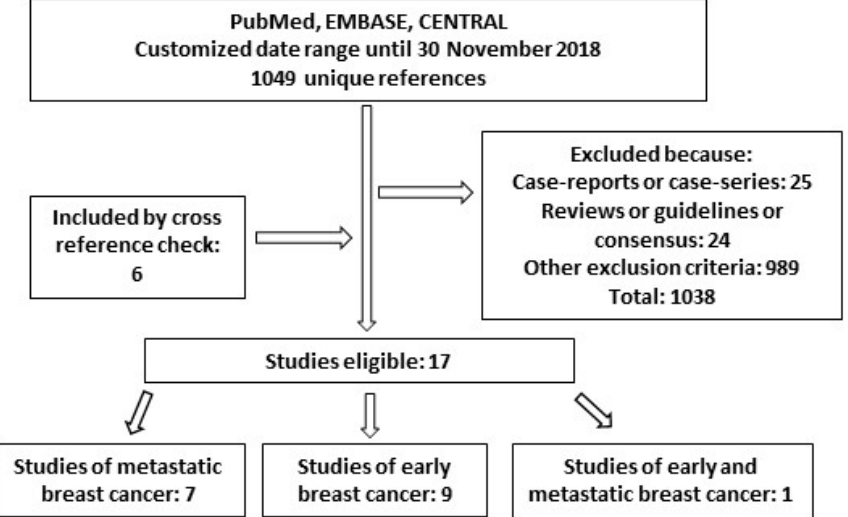
Figure 1. Diagram of studies found for “long-term safety” of trastuzumab in this review.